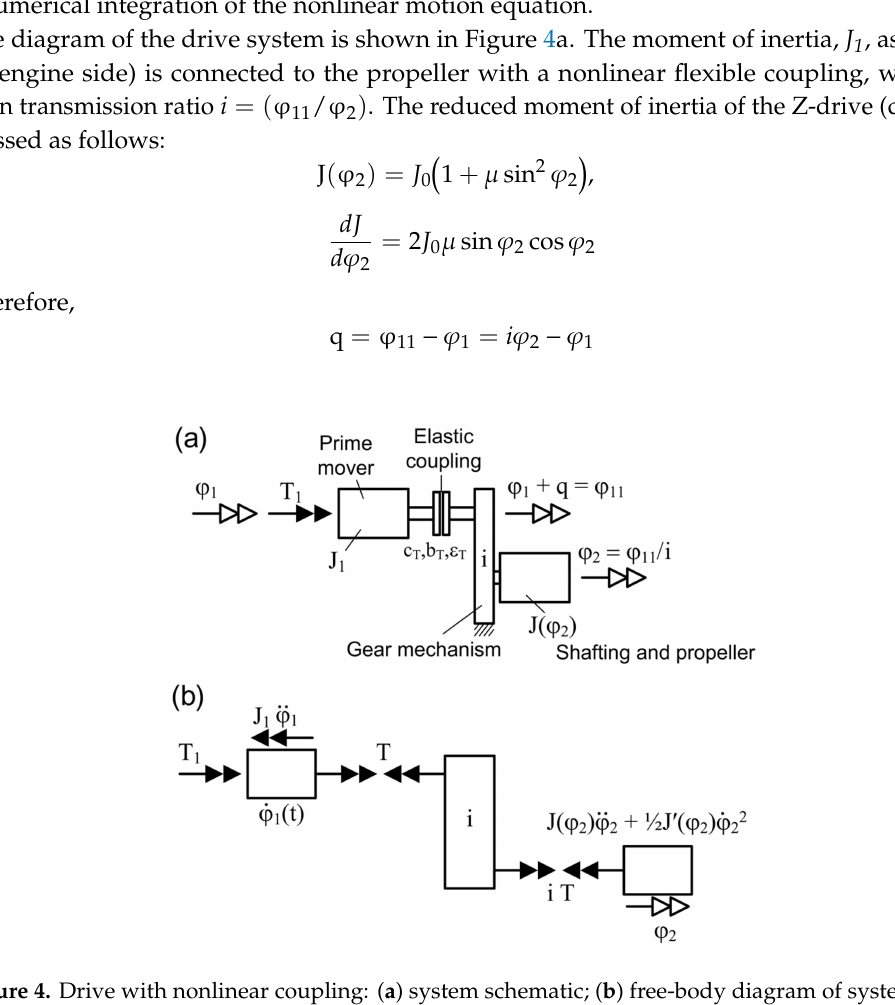
Figure 4. Drive with nonlinear coupling: ( a ) system schematic; ( b ) free-body diagram of system and occurring